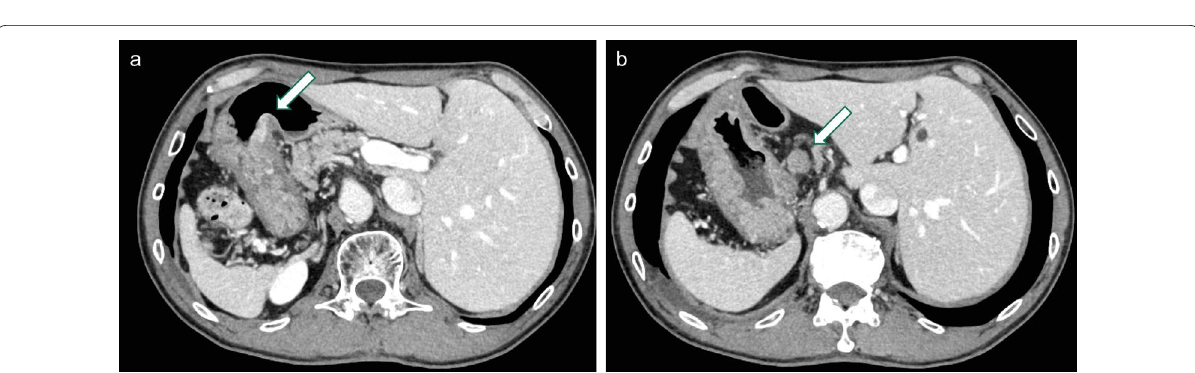
Fig. 2 Computed tomography (CT) findings. CT showed complete transposition of the abdominal organ, irregular thickening of the gastric wall ( a , arrow), and metastasis to lymph node #7 ( b ,